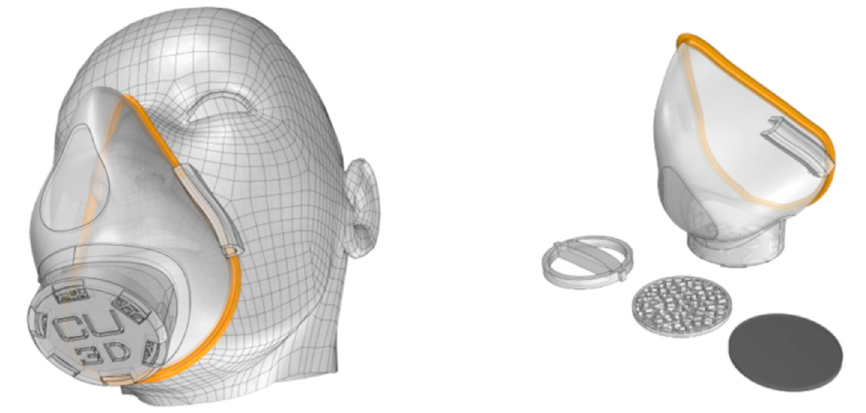
Figure 8. NanoHack mask printed with a recyclable and biocompatible polymer PLActive.